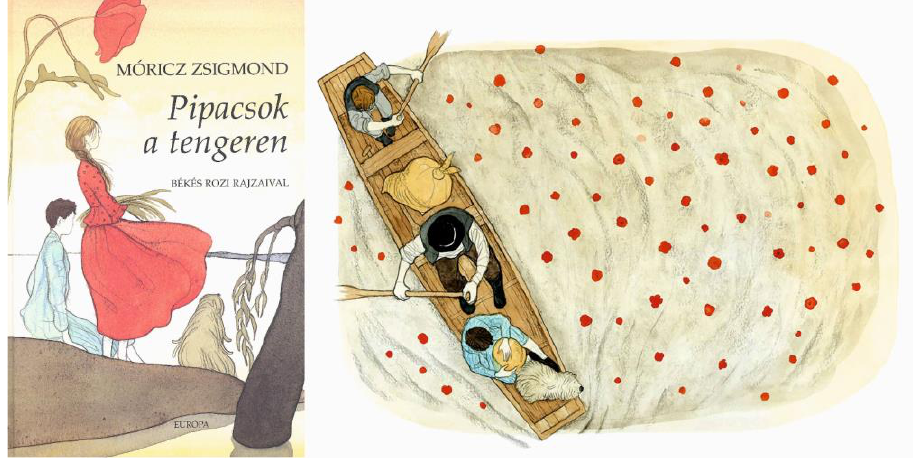
Figure 13. Drawings by Rozi Békés for the illustration of Zsigmond Móricz ’ s novel “ Poppies on the sea ” (1908), where a major flood on the Tisza river causes the red flowers to float (Courtesy of Rozi Békés).